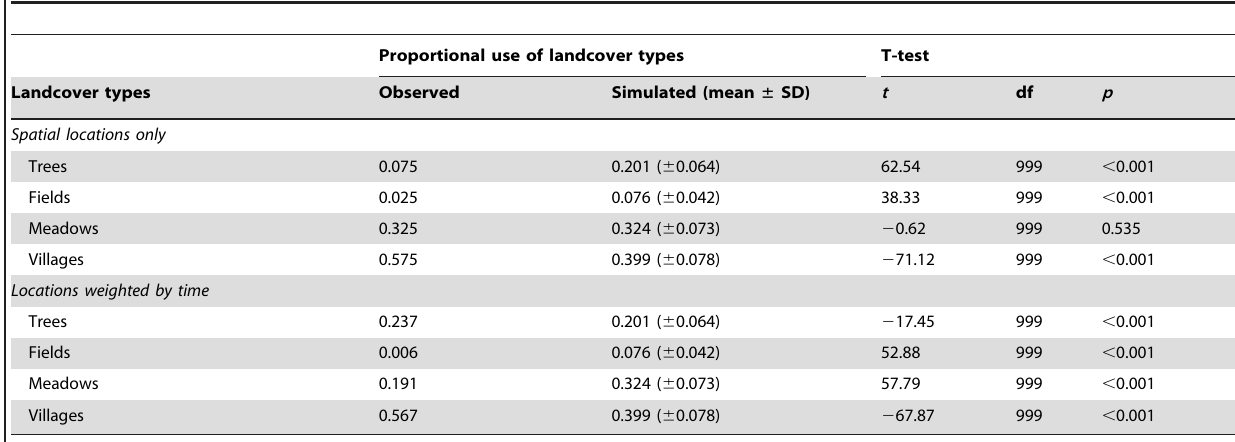
Table 2. Proportional use of landcovertypes of one bumblebee individual ( Bombus hortorum , bee 1, Table